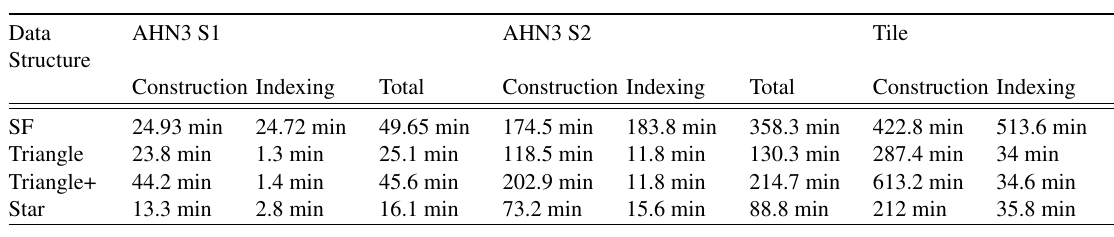
Table 3: Runtime for the pipeline